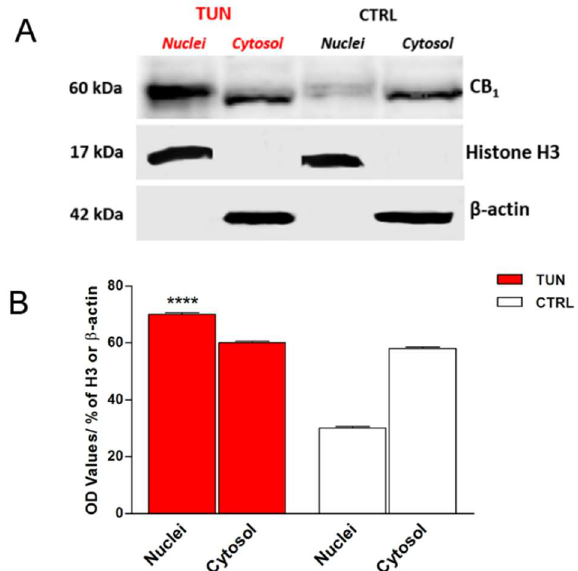
Figure 3. Co-localization of eCB-binding receptors with N -acetylglucosamine (GlcNAc). Representative triple immunofluorescence staining of GlcNAc (green), eCB-binding receptors (red), and DAPI (blue) in SH-SY5Y cells. SH-SY5Y cells were incubated with a biotinylated lectin (WGA) to visualize total GlcNAc, and with specific antibodies [anti-CB 1 ( A ), anti-CB 2 ( B ), anti-GPR55 ( C ), and anti-TRPV1 ( D )] for eCB-binding receptors; then with Alexa Fluor 488-labelled streptavidine for GlcNAc residues, with anti-rabbit IgG labeled with Alexa Fluor 595 for eCB-binding receptors and with DAPI for DNA. Scale bars = 50 µm.